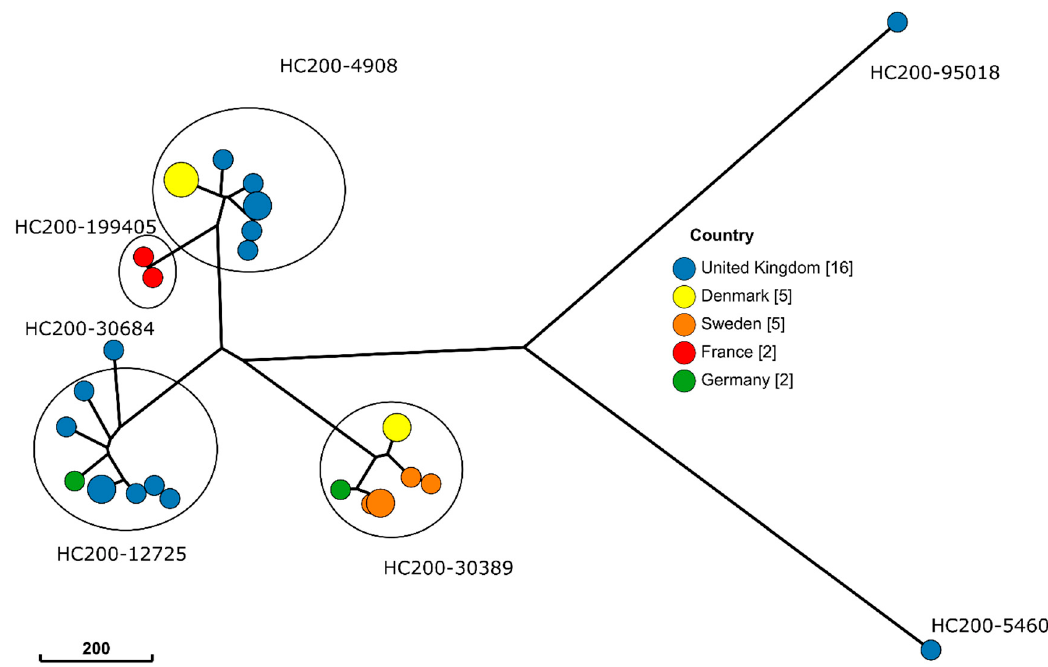
Figure 1. Neighbor-joining tree (NJTree) of European Salmonella Gallinarum strains, available from the EnteroBase data collection, compared using the EnteroBase cgMLST scheme.